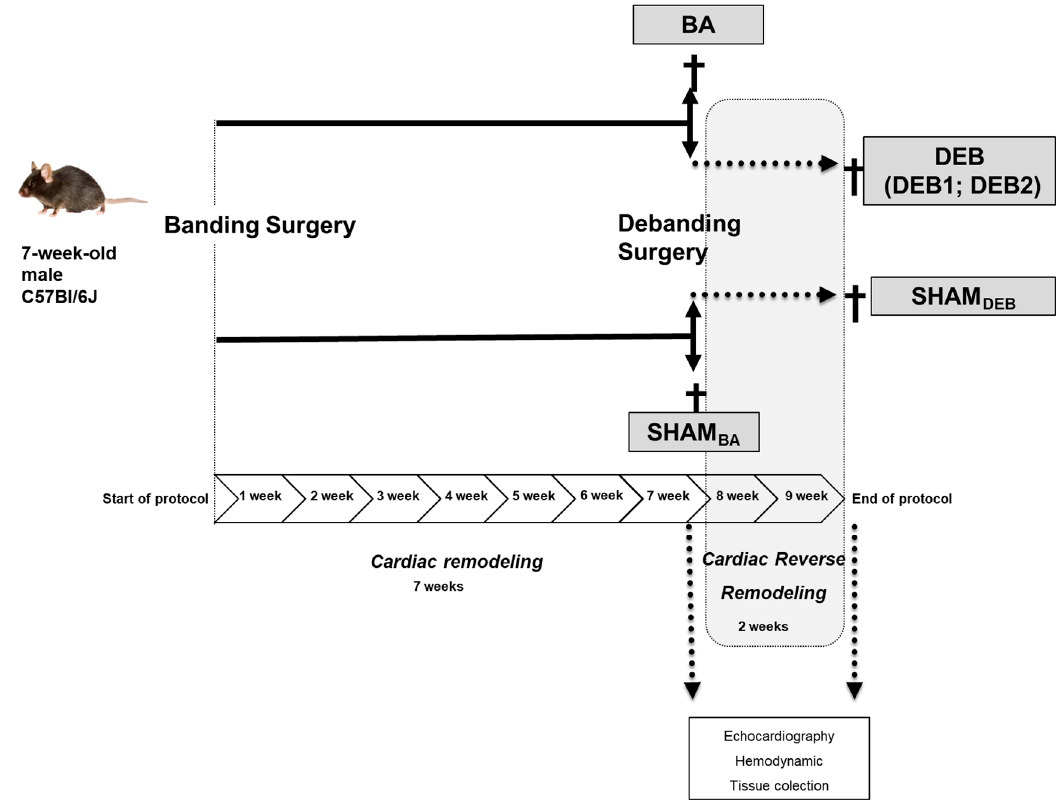
Figure 7. Study design. Seven-week-old C57Bl/6J mice were subjected to ascending aorta constriction (BA group) or a loose suture around the aorta (SHAMBA). After seven weeks, a second surgery was performed in half of BA and SHAM animals to remove the ascending aorta constriction or loose suture (debanding surgery). After two weeks of reverse remodelling, echocardiography and hemodynamic evaluation were performed, followed by animal termination (DEB and SHAM DEB groups). Echocardiographic assessment of the DEB group unveiled the existence of two DEB subgroups with distinct degrees of cardiac dysfunction, namely increased LV mass and severe diastolic dysfunction (DEB1 subgroup) and a second group with increased LV mass but normal diastolic dysfunction (DEB2